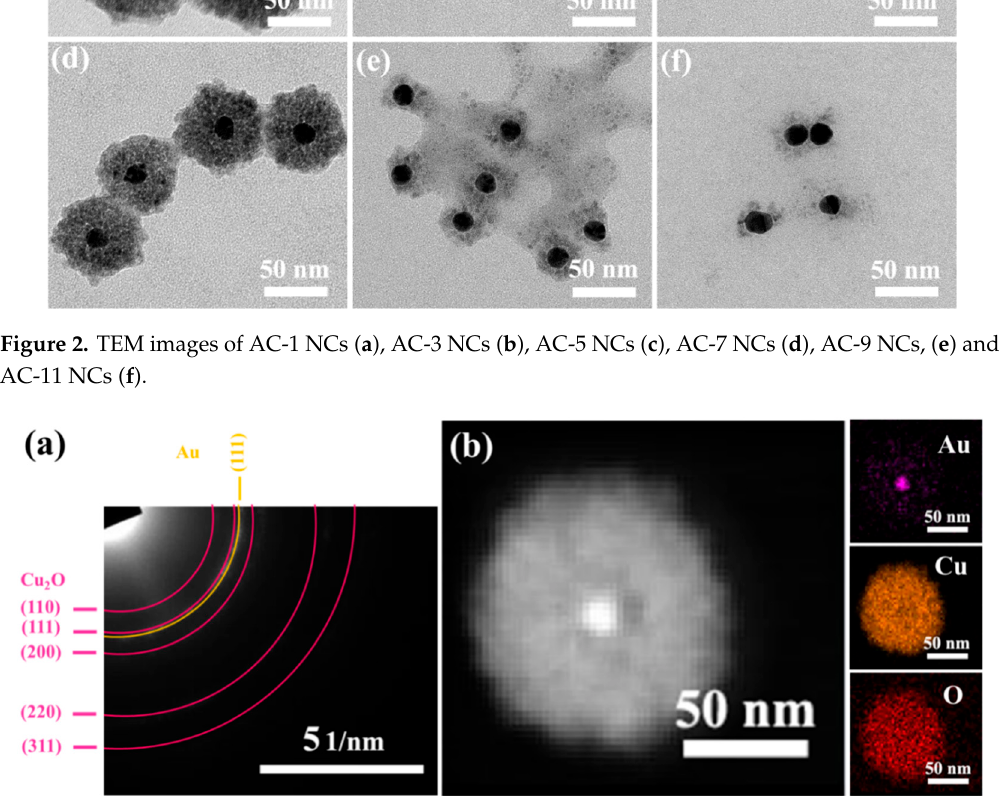
Figure 3. SEAD pattern ( a ) and HAADF-STEM images ( b ) of AC-1 NCs with corresponding EDS elemental mapping images (Au, Cu, and O).